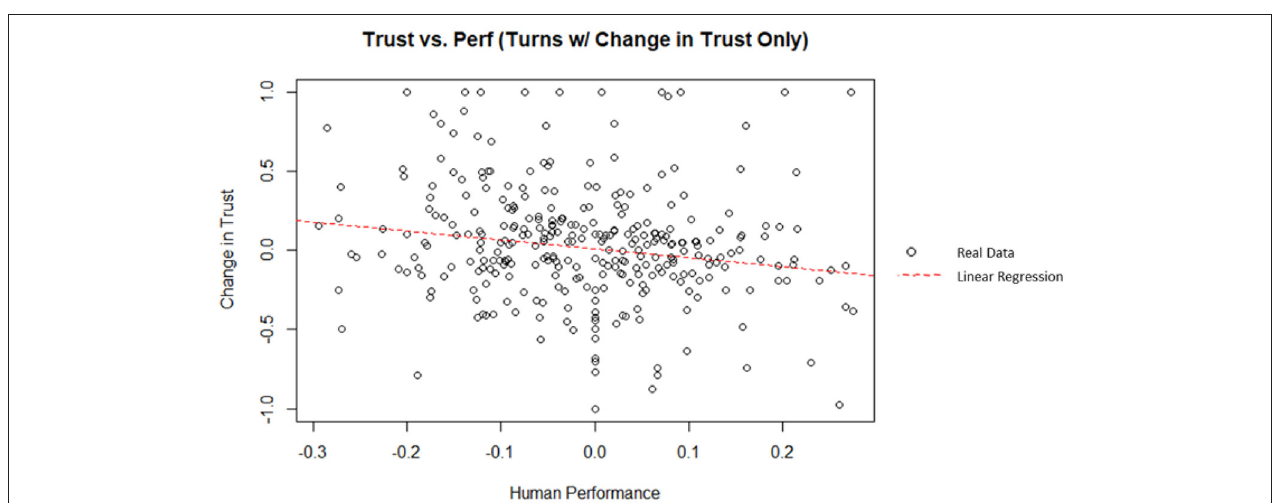
FIGURE 11 | Human performance vs. change in trust (filtered for turns with a change in trust).